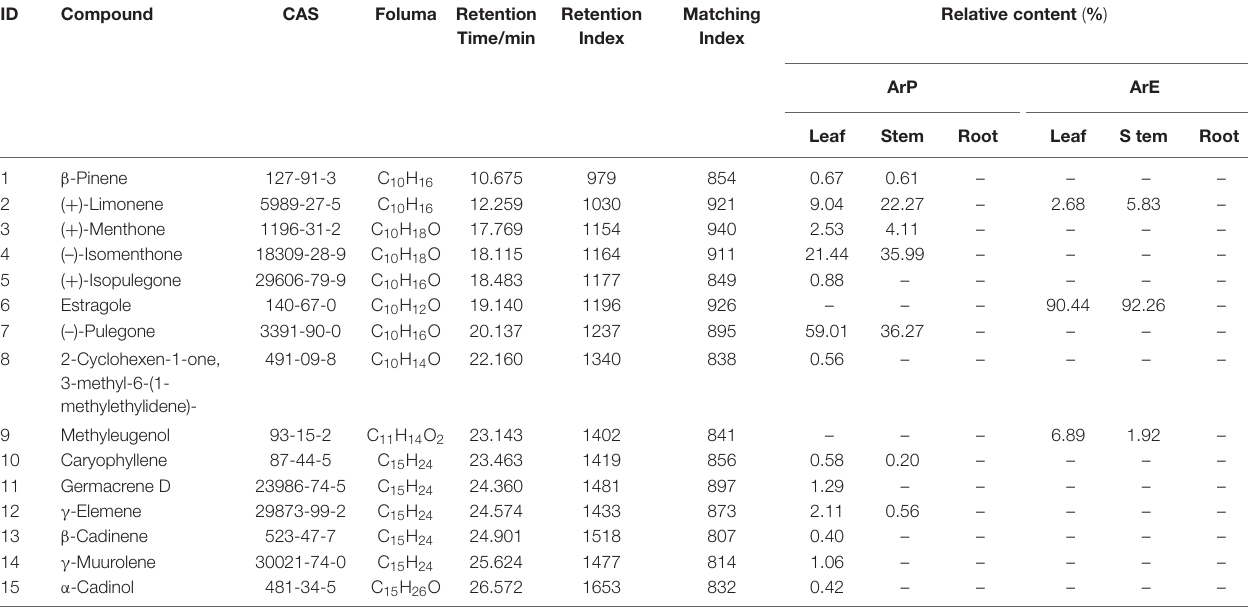
TABLE 1 | The content of the main component in volatile oil from different parts of A.